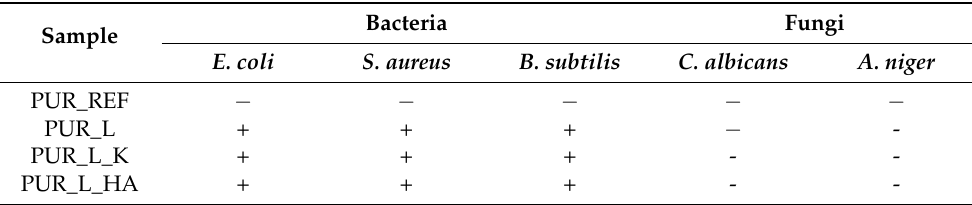
Table 4. Antibacterial properties of PUR composites against selected bacteria and fungi. Bacteria Sample